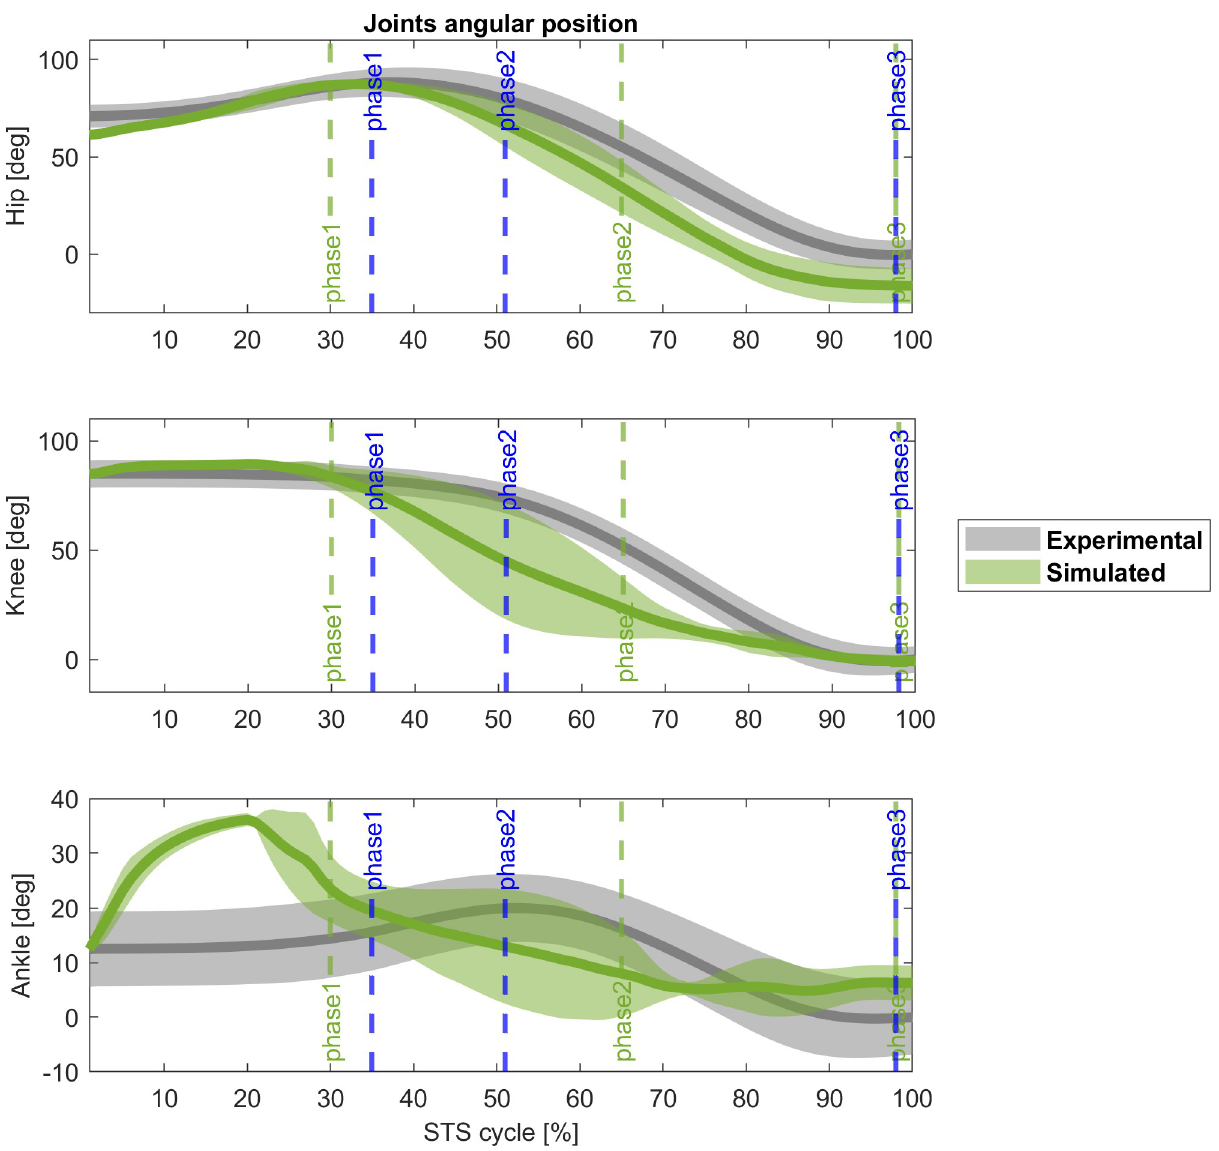
Fig 4. Experimental (grey) and 4-phases controller (green) joint angles [deg] comparison (mean ± std). Blue vertical lines: experimental cycle times; green vertical lines: 4-phases controller cycle times. Cross-correlation coefficient: r(hip) = 0.99 ( Δ = 0%), and r(knee) = 0.93 ( Δ = 0%), r(ankle) = 0.68 ( Δ =